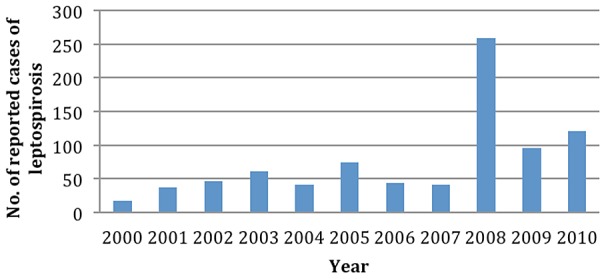
Suspected cases of leptospirosis reported to the regional epidemiologist Anuradhapura during 2000–2012 period.